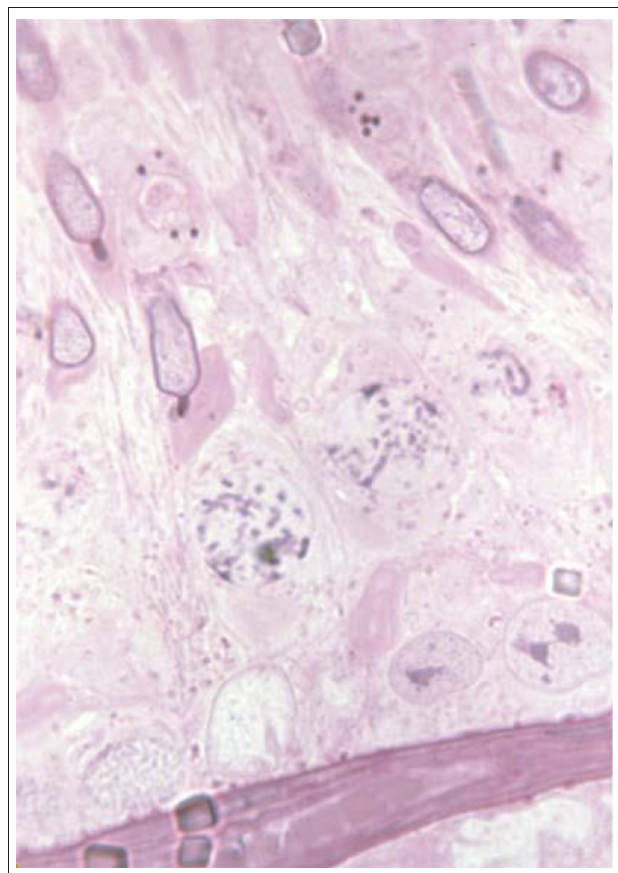
FIGURE 2 | Images of the developing knobbed acrosome defect. Courtesy of Professor Albert